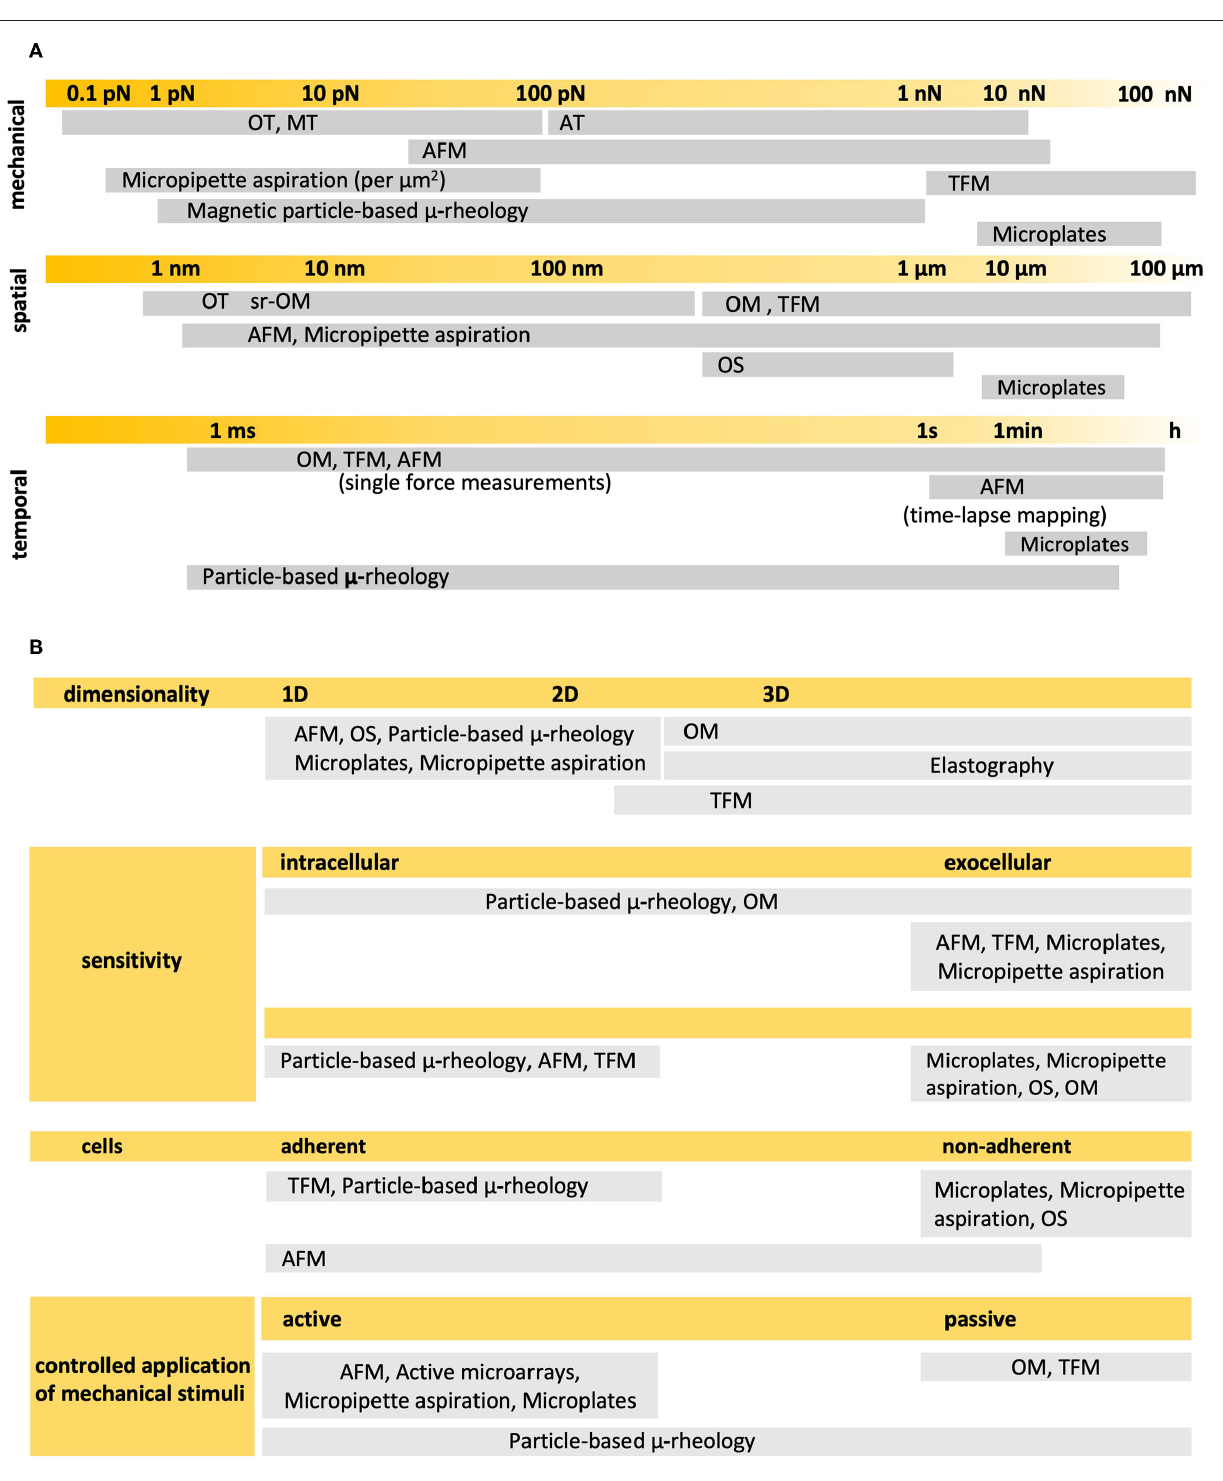
FIGURE 2 | Experimental techniques most commonly used in single cell mechanics (A) Detection ranges in the mechanical, spatial and temporal scales of relevance. (B) Main characteristics. OM, Optical Microscopy; AFM, Atomic Force Microscopy; TFM, Traction Force Microscopy; OT, Optical Tweezers; MT, Magnetic Tweezers; AT, Acoustic Tweezers; OS, Optical Stretcher. Particle-based techniques may comprise optical or magnetic drag, tweezers or traps, and twist cytometry. Sources: (Thoumine and Ott, 1997; Hochmuth, 2000; Lau et al., 2003; Wottawah et al., 2005; Basoli et al., 2018; Septiadi et al., 2018; Wu et al., 2018).